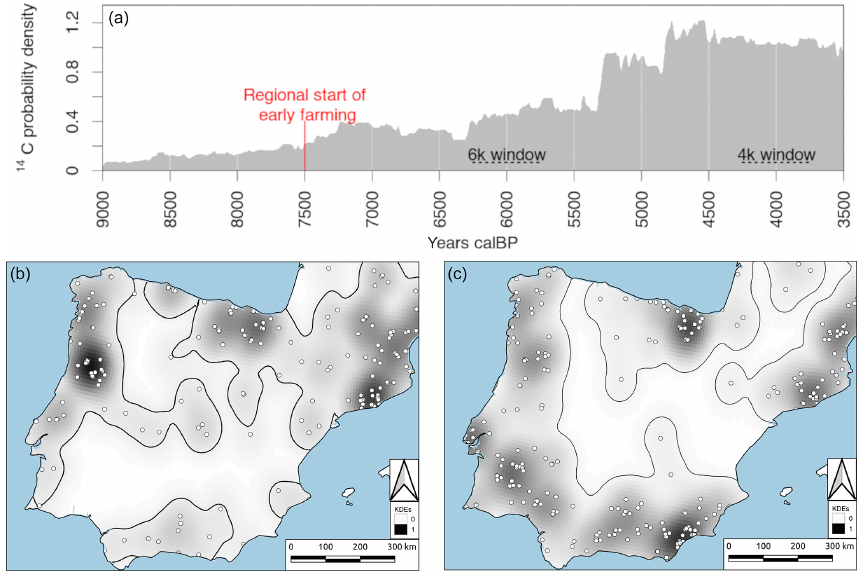
Figure 3. Reconstruction of changes in population size on the Iberian Peninsula during the Holocene (9000 to 2000BP, 9ka to 2kaBP) using summed probability distributions (SPDs) of radiocarbon dates (a) (data after Balsera et al., 2015). The red line indicates the onset of agriculture in the region. Panels (b) and (c) show areas under human use at 6ka (b) and 4ka (c) using kernel density estimates; the white dots are actual archaeological sites, and the shading shows the implied density of